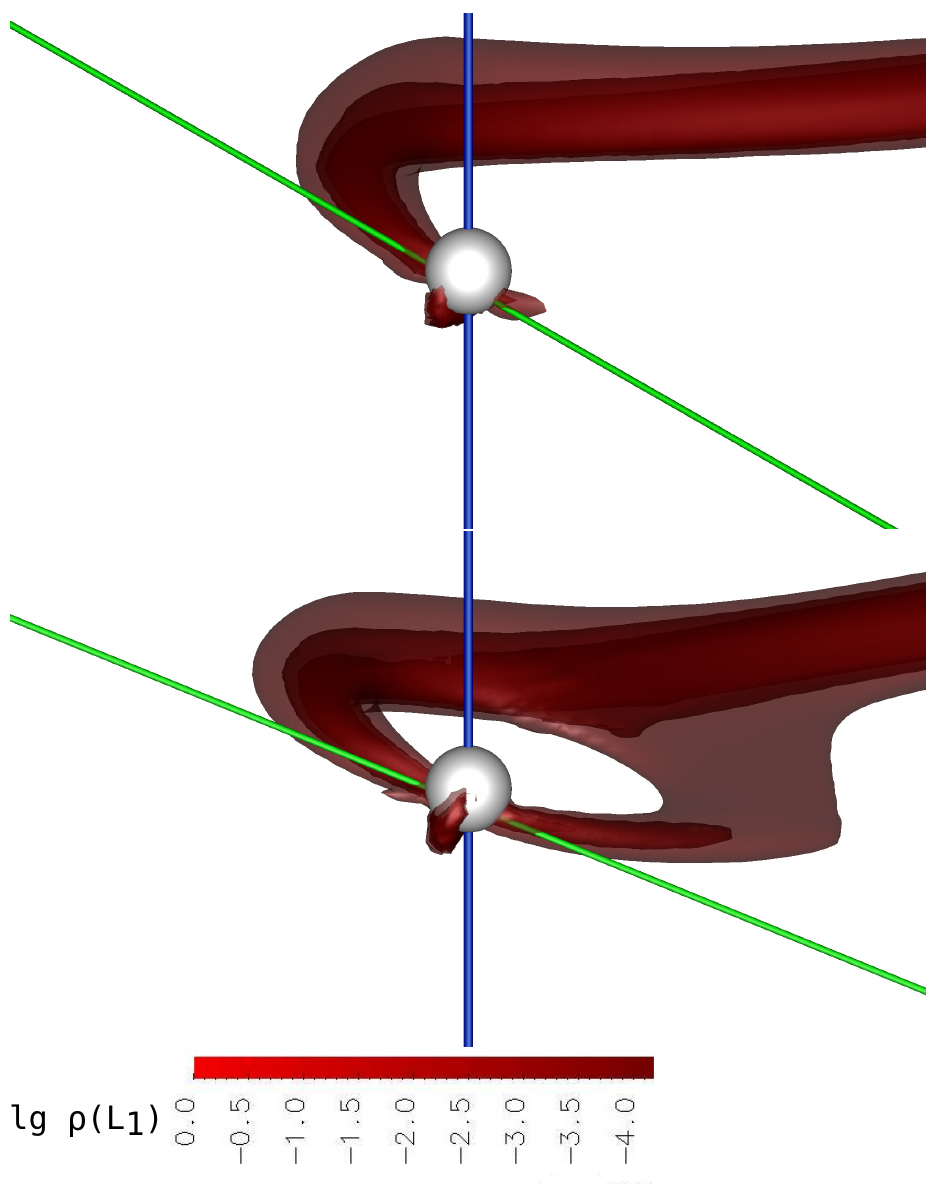
Figure 12. The three-dimensional numerical modeling results of the matter flow structure in the asynchronous polar with an offset dipole for the moment of switching from the north magnetic pole to the south one. The iso-surfaces of the decimal logarithm of the density are presented in units of ρ ( L 1 ) . The surface of the accretor is shown as a white sphere. The binary system is at the orbital phase 0.4. The upper panel coincides with Phase 1, and the lower panel with Phase 2 of the switching